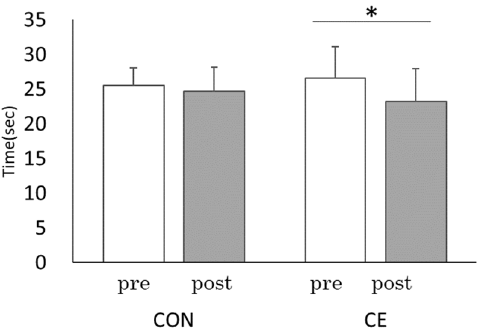
Figure 4. Comparisons of each trial between pre and post: TMT-B. CE: Co-kara exercise experiment; CON: Control experiment; pre: before Co-kara exercise; post: after Co-kara exercise. ( n = 9) pre- vs. post, CE: * p < 0.05 ( p = 0.018, r = 0.73), CON: not significant ( p = 0.38, r = 0.31).